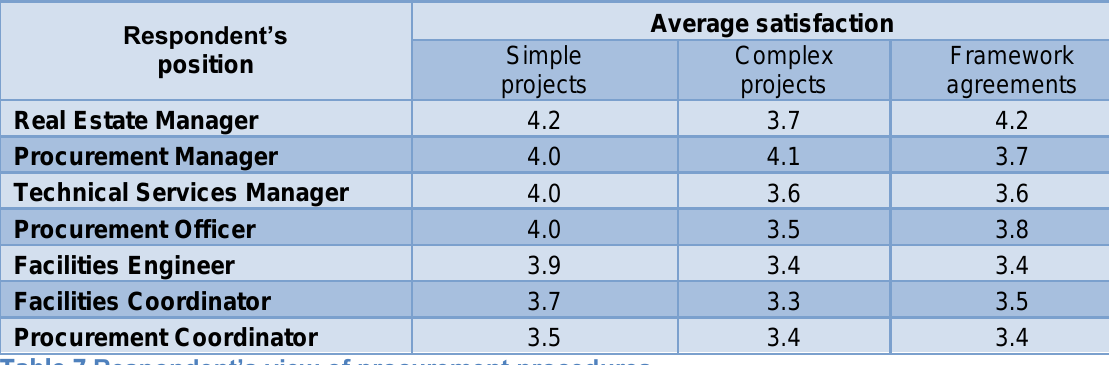
Table 7 Respondent‟s view of procurement procedures (five- degree scale, where 1 = bad, 5 = very good) compared with respondent’s position within the organisation